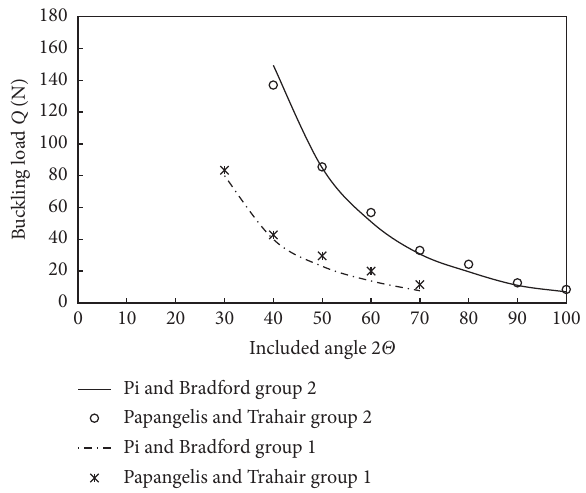
Figure 6: Comparison of numerical and test results [58,